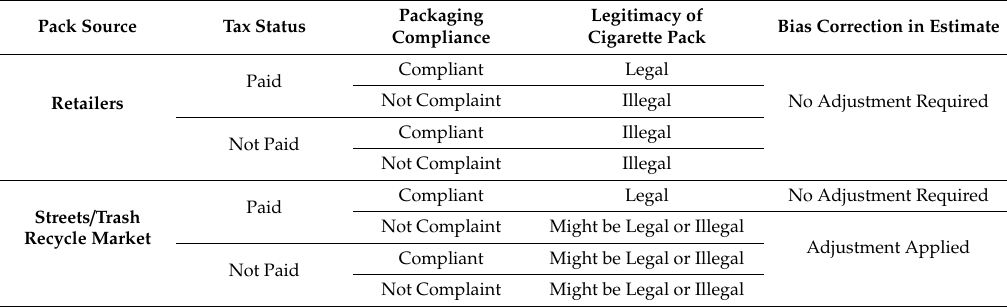
Table 3. Legitimacy Criterion of Cigarette Pack and Bias